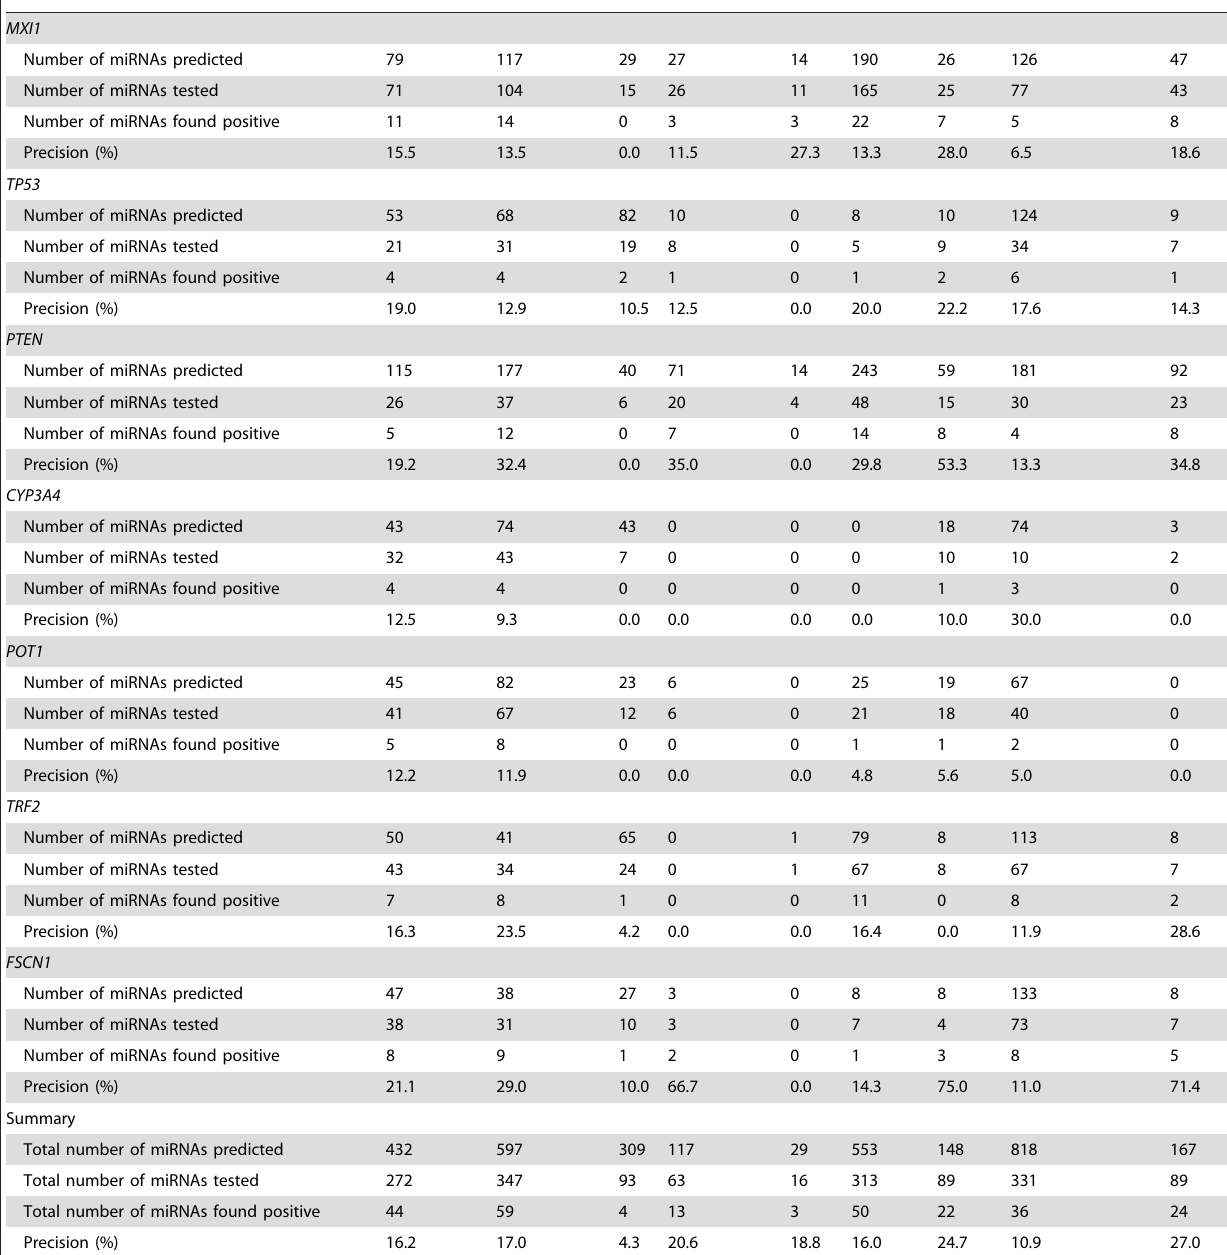
Table 1. Summary of prediction